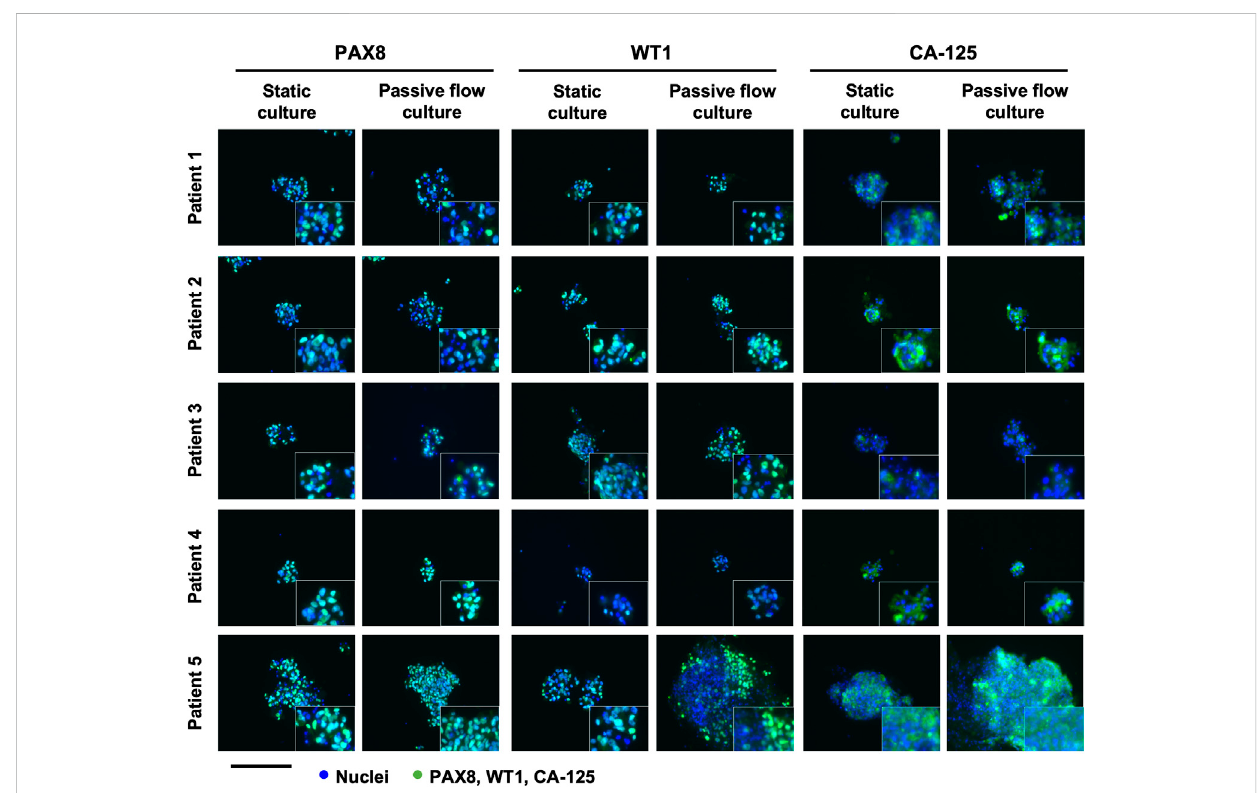
FIGURE 5 Characterization ofthe organoids instaticand passive fl owconditions:Immuno fl uorescentimages of organoids show typicalHGSOC markers: cell nucleiareinblueandcellslabeledwithPAX8,WT1,andCA-125areingreen.Thesamemarkersaredetectedinstaticandpassive fl owcultures.Insertsare cells zoomed 4×. Scalebar is 250 μ